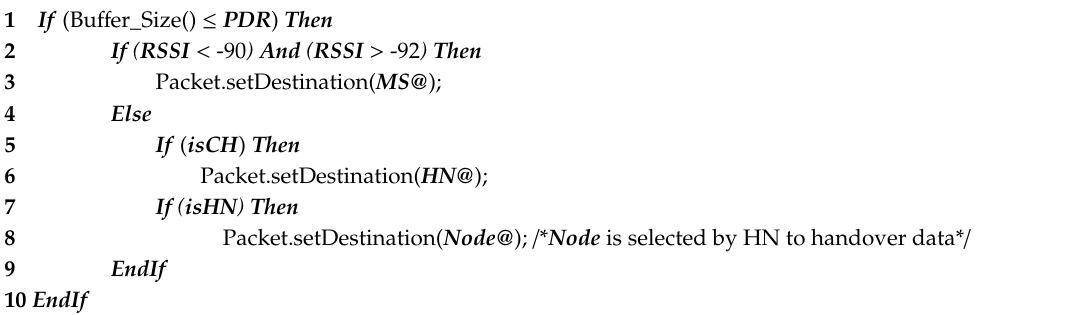
Algorithm 5 Control mechanism for transmitting data from bu ff er of